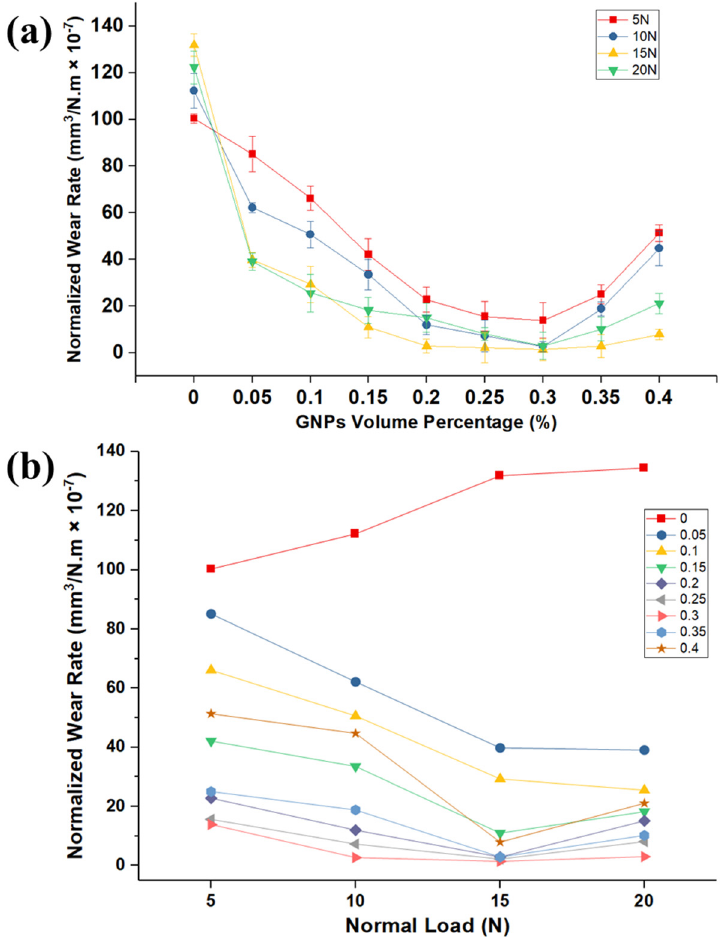
Figure 5. ( a ) The variation of wear rate in different volume percentage of GNPs at several loads. ( b ) The variation of wear rate in different loads at several volume percentages of GNPs.